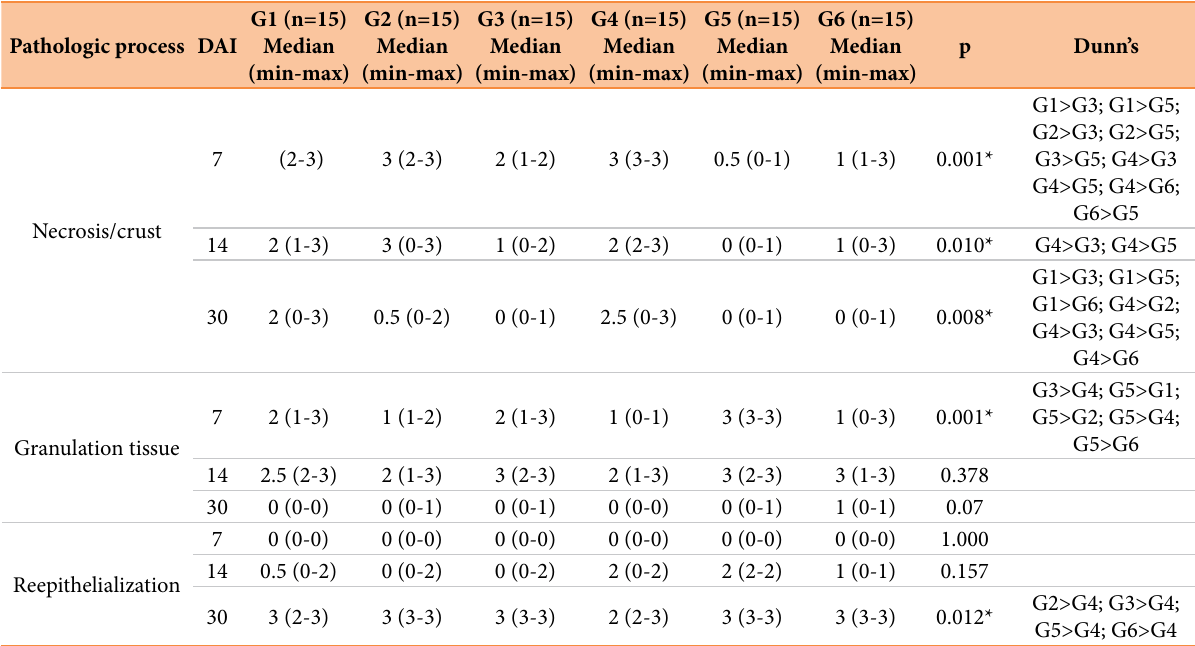
Table 1 - Macroscopic analysis of the general pathologic processes in burn wounds experimentally induced in Wistar rats and treated with silver-based